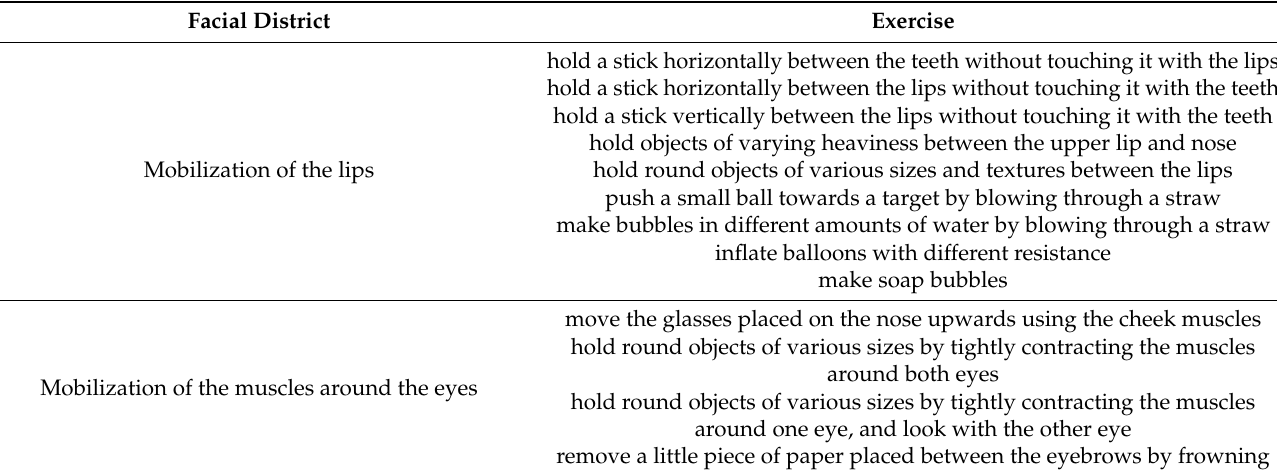
Table 4. List of facial